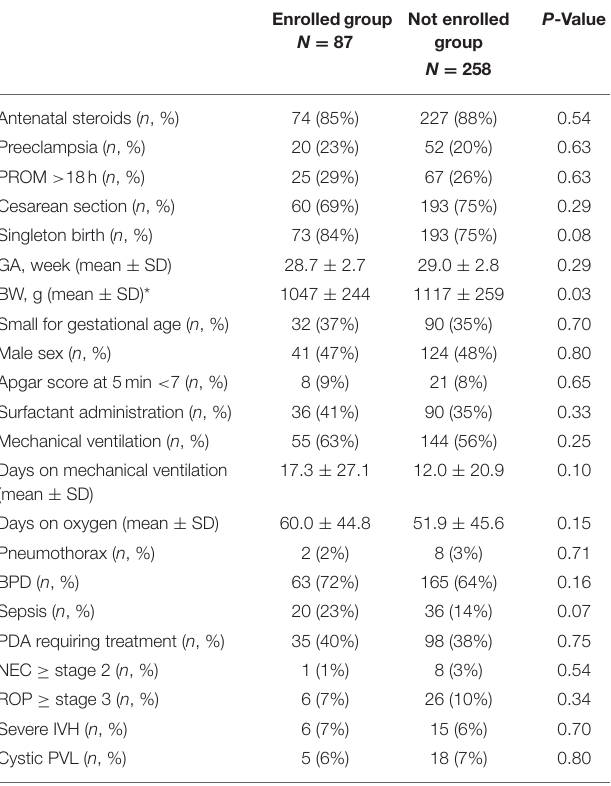
TABLE 2 | Characteristics of the study population at the time of the heart function test. Pretermgroup N =